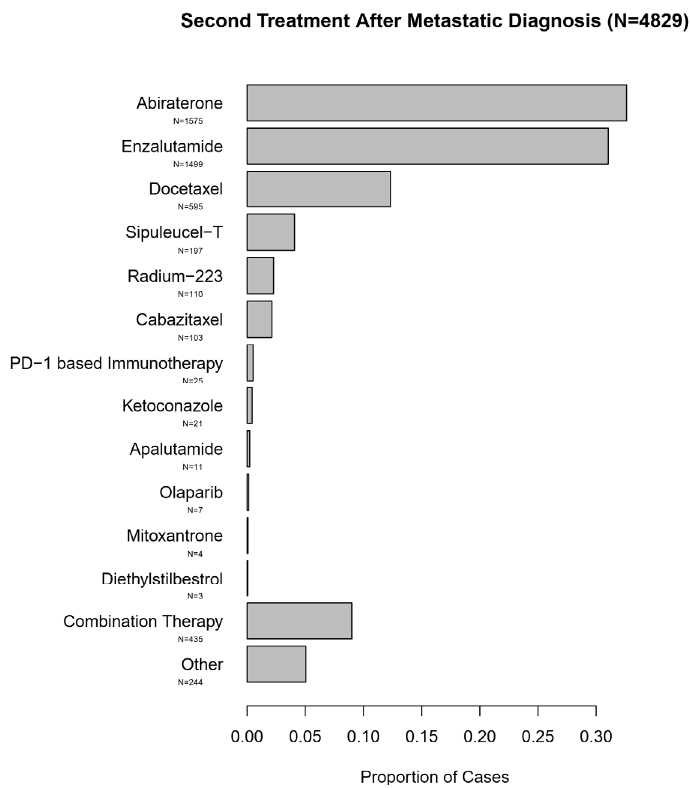
Figure 4. Second Treatment After Metastatic Diagnosis ( N = 4829).